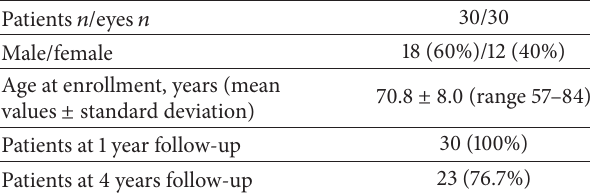
Table 1: Demographic characteristics.